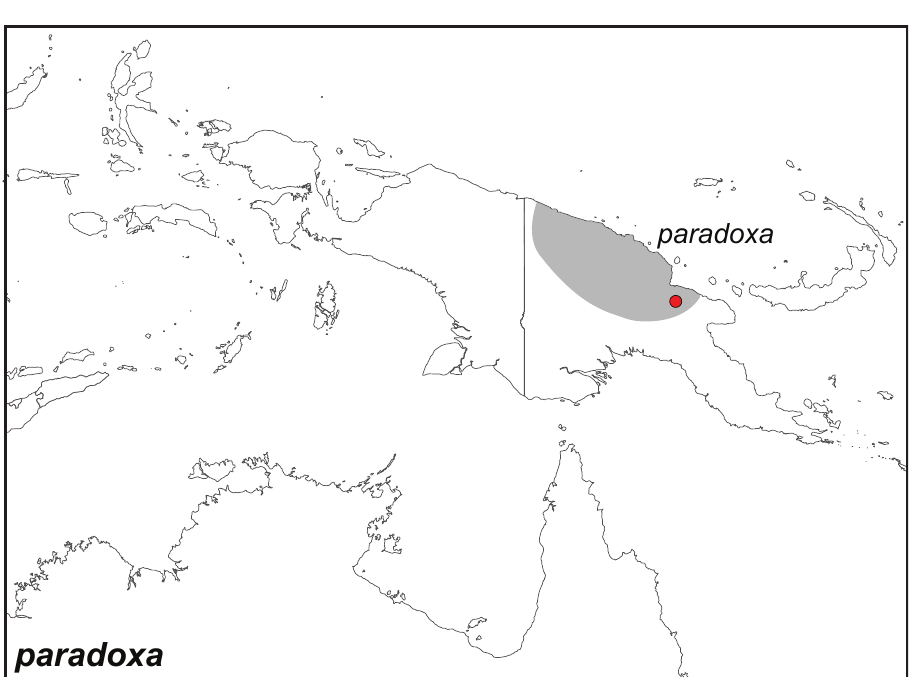
Figure 27. Distribution map of Elymnias bammakoo.